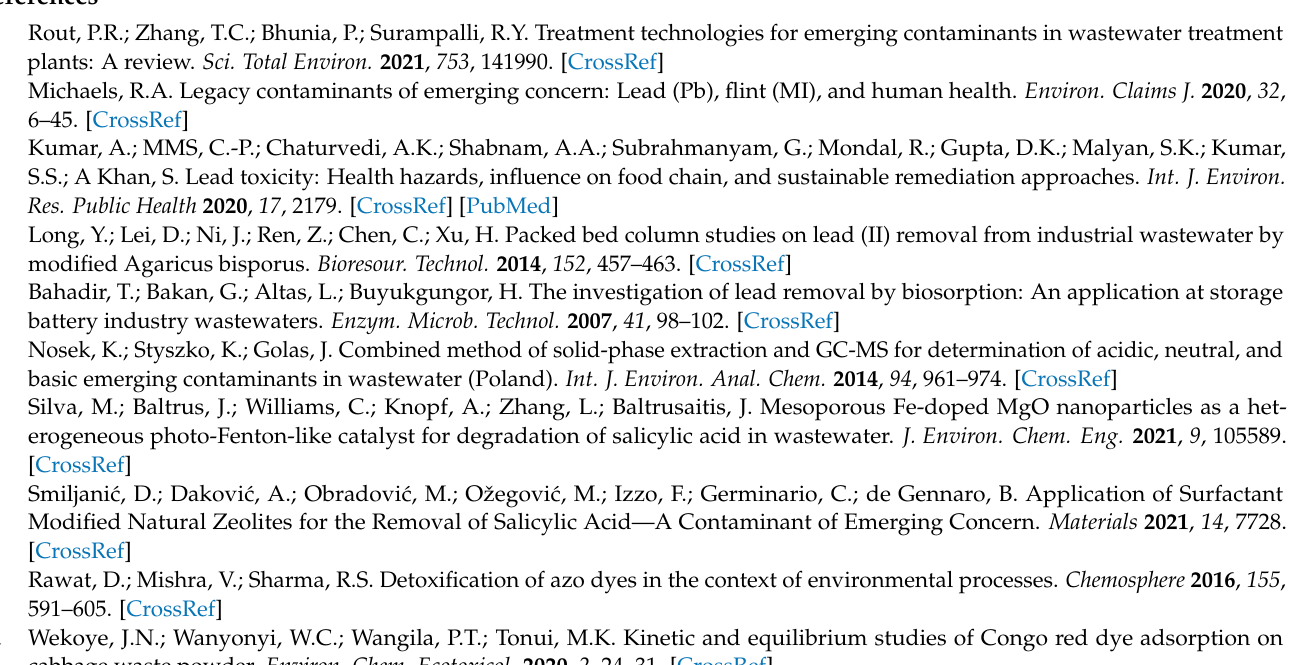
Figure S3: BET isotherms for chitosan (a), xylan (b), chitosan/xylan (c), CsXM (d), CsM (e), and XnM (f); Figure S4: Pore volume distribution for chitosan (a), xylan (b), chitosan/xylan (c), CsXM (d), CsM (e), and XnM (f); Figure S5: Normalized kinetic plots for the effect of contact time (a), pseudo-second order linear fits for the adsorption of Pb(II) (b), SA (c), and CR (d), and (e) intra-particle diffusion fits for the adsorption of Pb(II), SA, and CR. Initial concentration of tested contaminants was 50 ppm, adsorbent dose was 0.67 g/L at 25 ◦ C ± 2, with pH of 5.5 ± 0.1, 4.0 ± 0.3, and 6.1 ± 0.2, for Pb (II), SA, and CR, respectively, and at room temperature; Figure S6: UV/VIS spectra for the ternary system comprising Pb(II), SA, and CR before adsorption at pH 5.5 (upper panel) and pH 4.0 (lower panel); Figure S7: FTIR peaks for CsXM before and after adsorption of Pb(II), SA, and CR; Table S1: XRD 2 θ values for both magnetite and CsXM; Table S2: BET measurements of particle